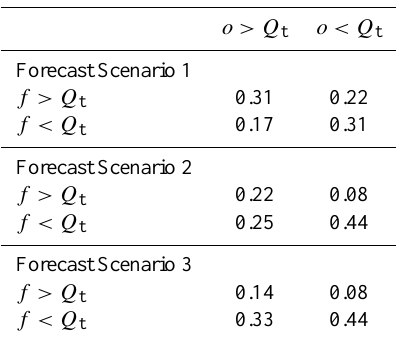
Table 2. Contingency tables of warnings outcomes for the three forecast